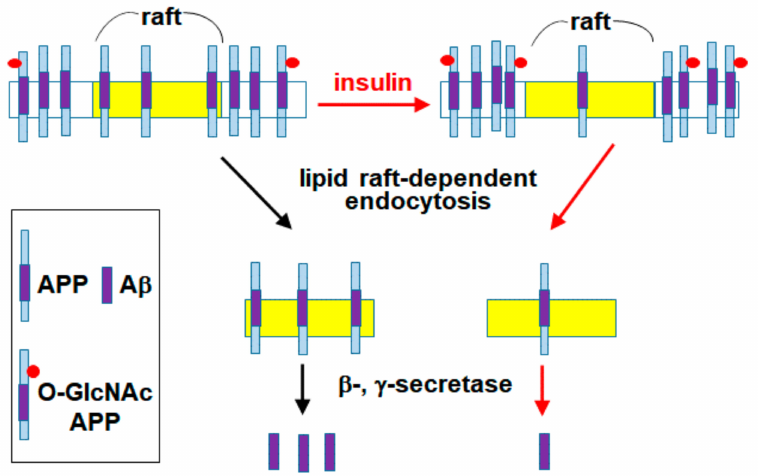
Figure 6. Our current model. APP O-GlcNAcylation in response to insulin signaling translocated APP from lipid rafts into non-rafts. Since APP would preferentially undergo endocytosis from lipid rafts and be cleaved by β -, γ -secretases in early endosomes and lysosomes, APP O-GlcNAcylation inhibited A β